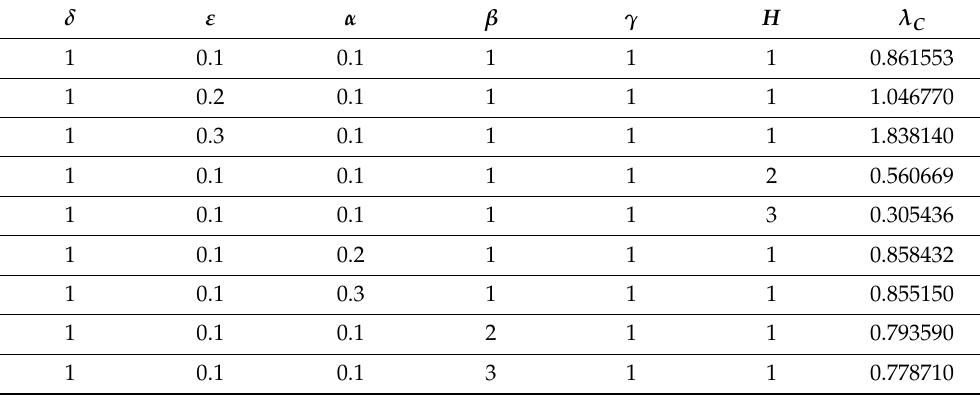
Table 5. Computation of Critical values of Frank–Kameneskii